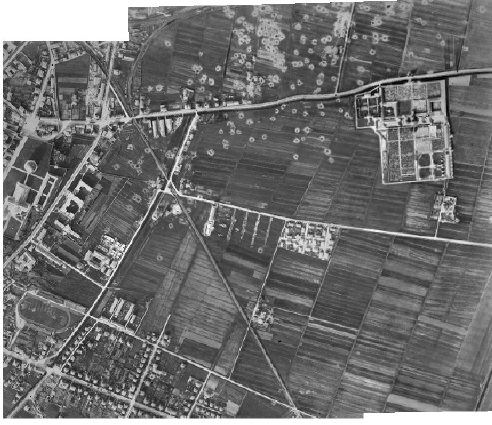
Two photos are stitched together using the transformation computed from the corresponding points (green crosses in Figure 1) in the overlapping area. ( c (cid:13) MiBAC-ICCD, Aerofototeca Nazionale, fondo